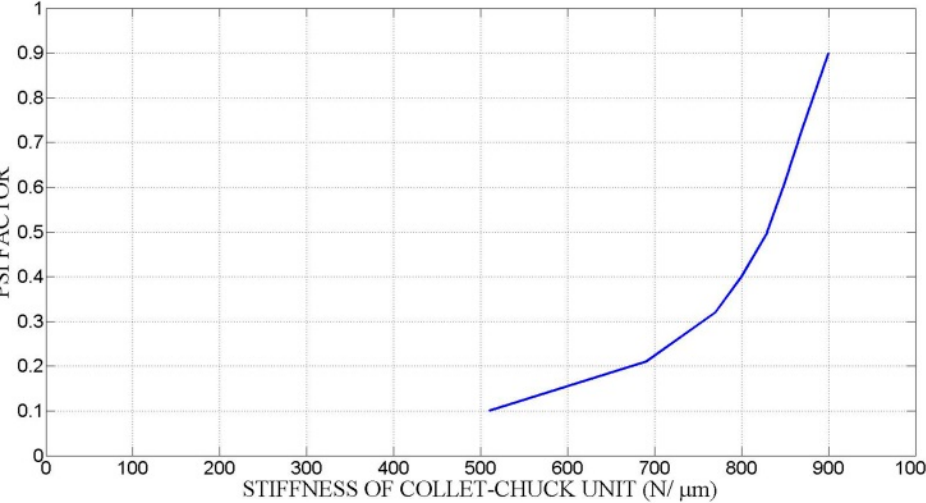
Figure 18. Influence of the stiffness of expanding mandrel and workpiece.